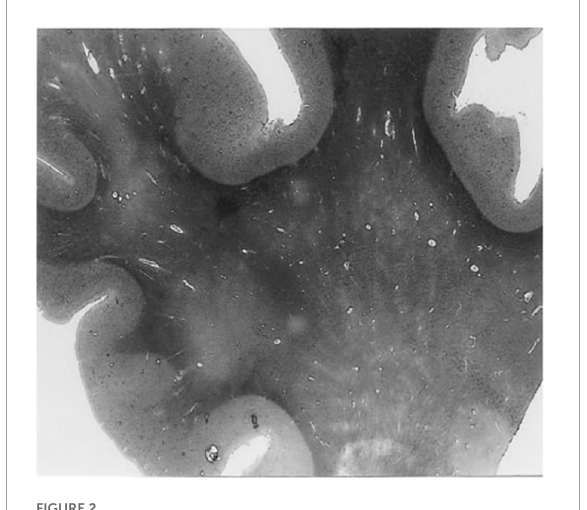
FIGURE2 A histological slice of the superior frontal gyrus from an Alzheimer’s disease patient with numerous enlarged perivascular spaces in the white matter (Roher et al., 2003). PVS appear as bright tubular structures and are mainly present in white matter as opposed to gray matter. Adapted from Roher et al. (2003) and reproduced with permission from Springer Nature, conveyed via the Copyright Clearance Center,